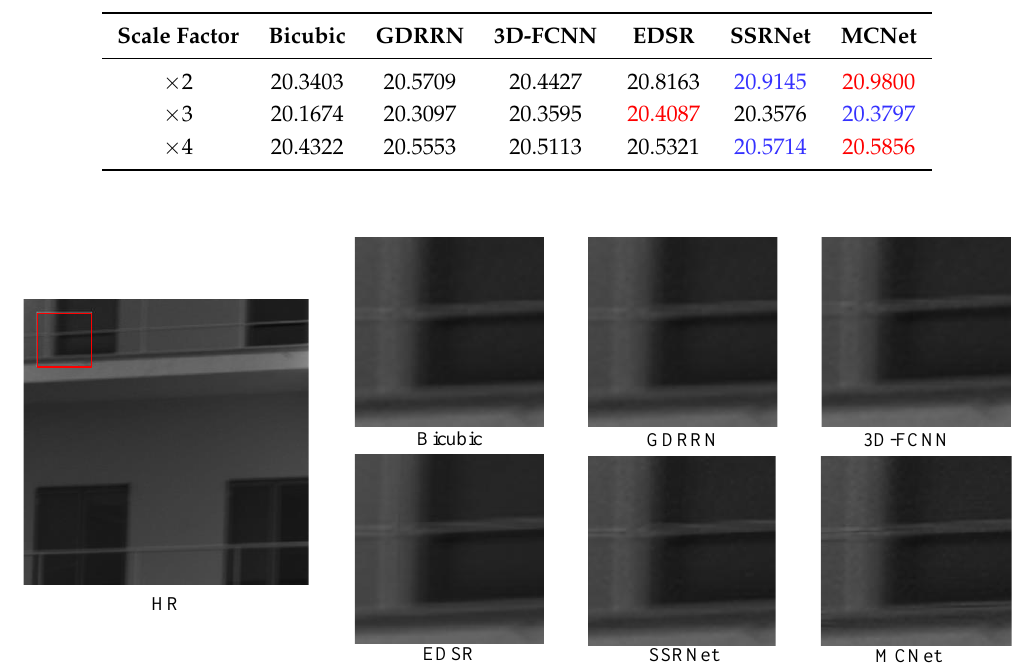
Figure 13. Visual comparison on real hyperspectral image dataset.